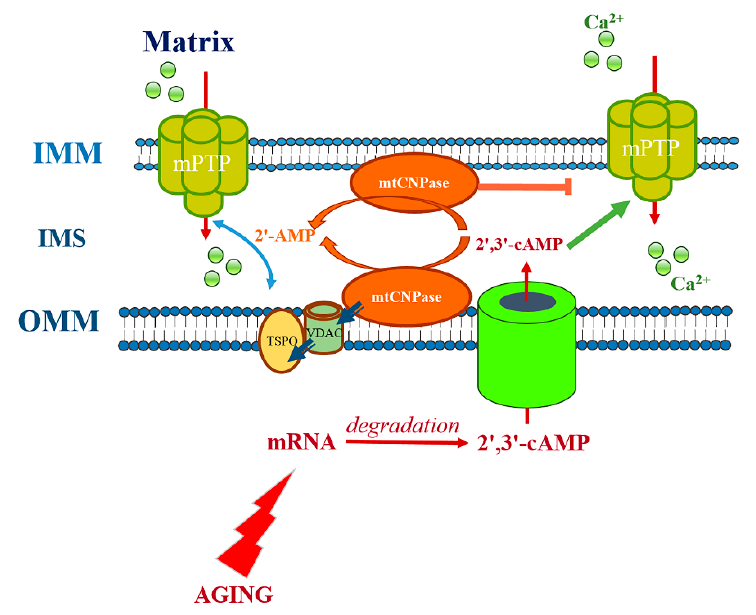
Figure 3. Role of CNPase in mitochondria in aging.